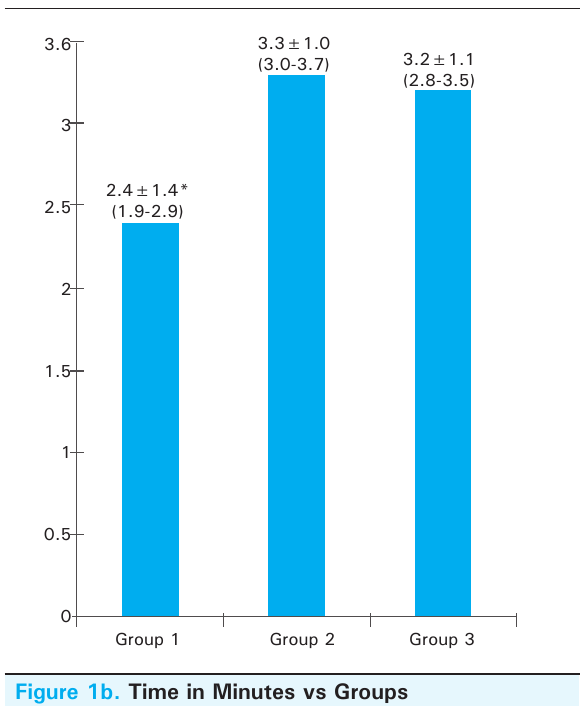
Figure 1b. time in Minutes vs groups